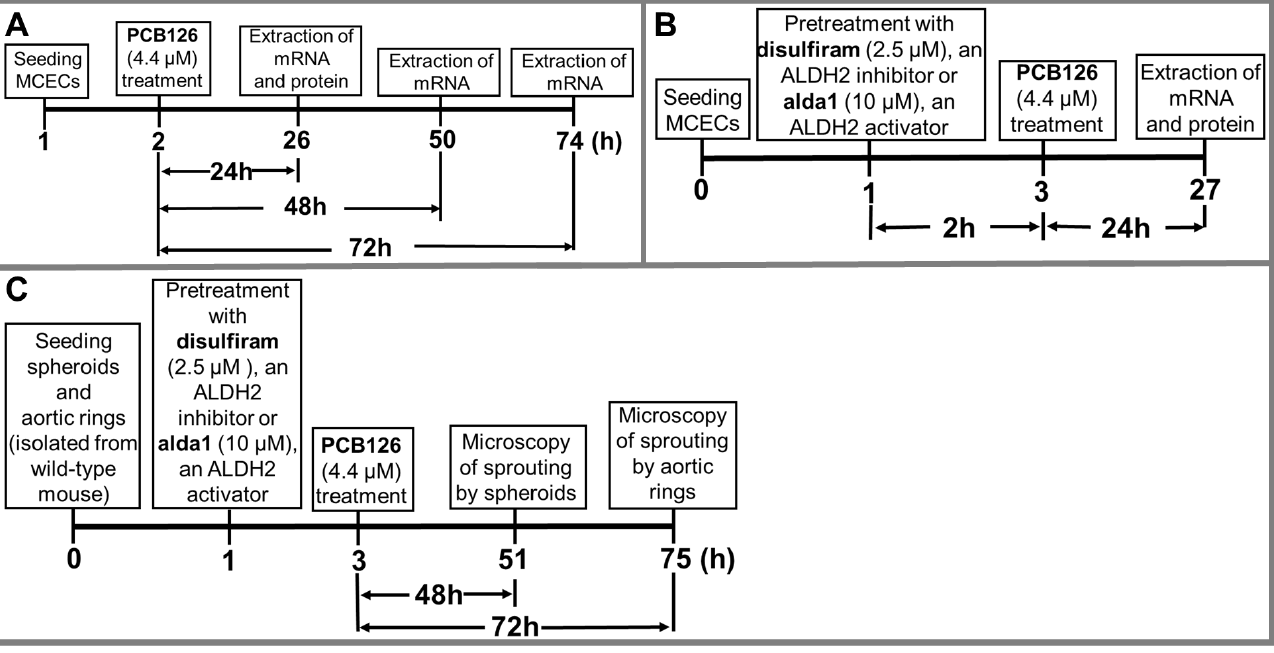
Figure 1. Treatment